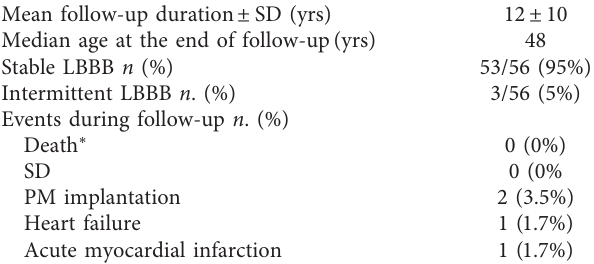
Table 3: Follow-up data. ∗ One patient suffered accidental death. Mean follow-up duration ± SD